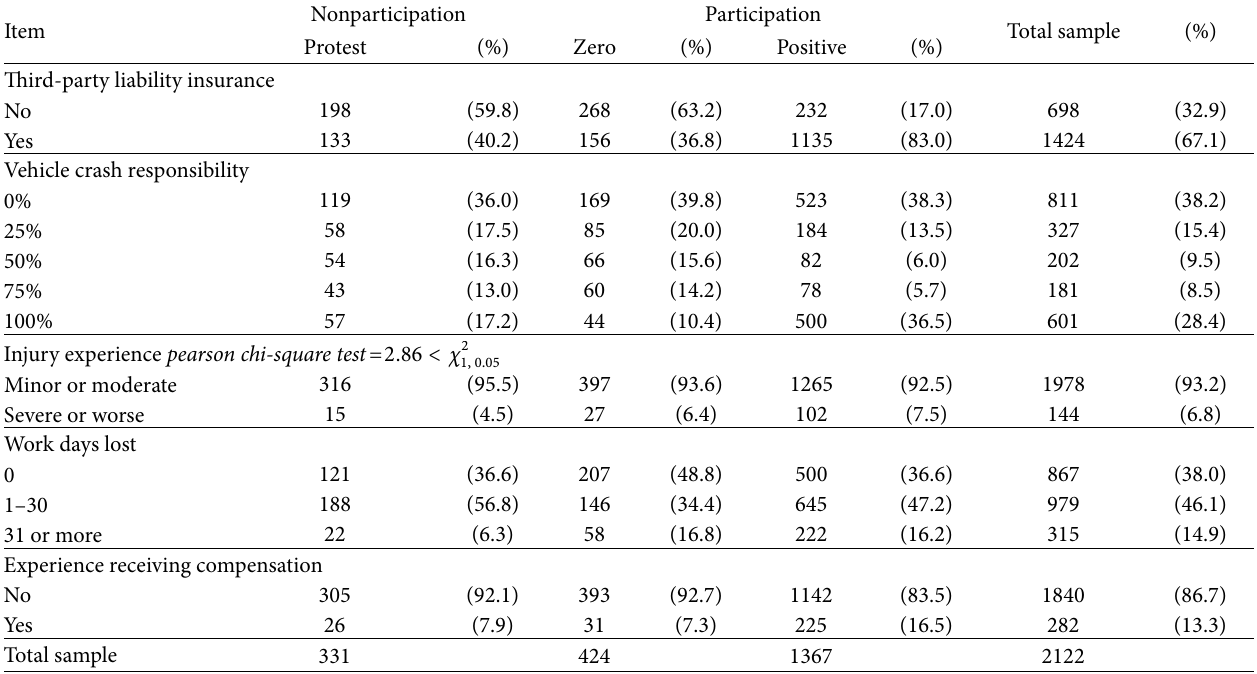
Table 2: Respondents’ accident